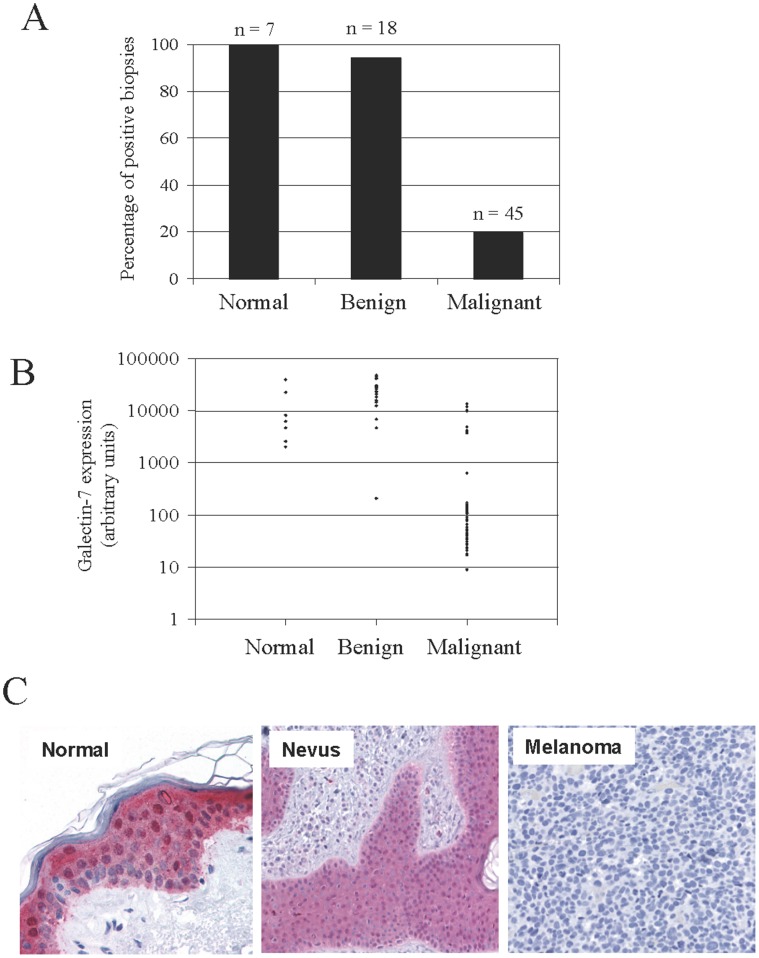
Galectin-7 expression in human melanoma tissues.A) Percentage of positive biopsies of normal skin (n = 7), nevus (n = 18) and malignant melanoma (n = 45), as determined by the in silico analysis of galectin-7 expression from a microarray of human biopsies [26]. B) Representative graph of galectin-7 mRNA expression in each biopsy described in (A). C) Detection of galectin-7 by immunohistochemistry in representative biopsies of nevi and malignant melanoma. Overall, 13 malignant melanomas and 47 nevi were tested.